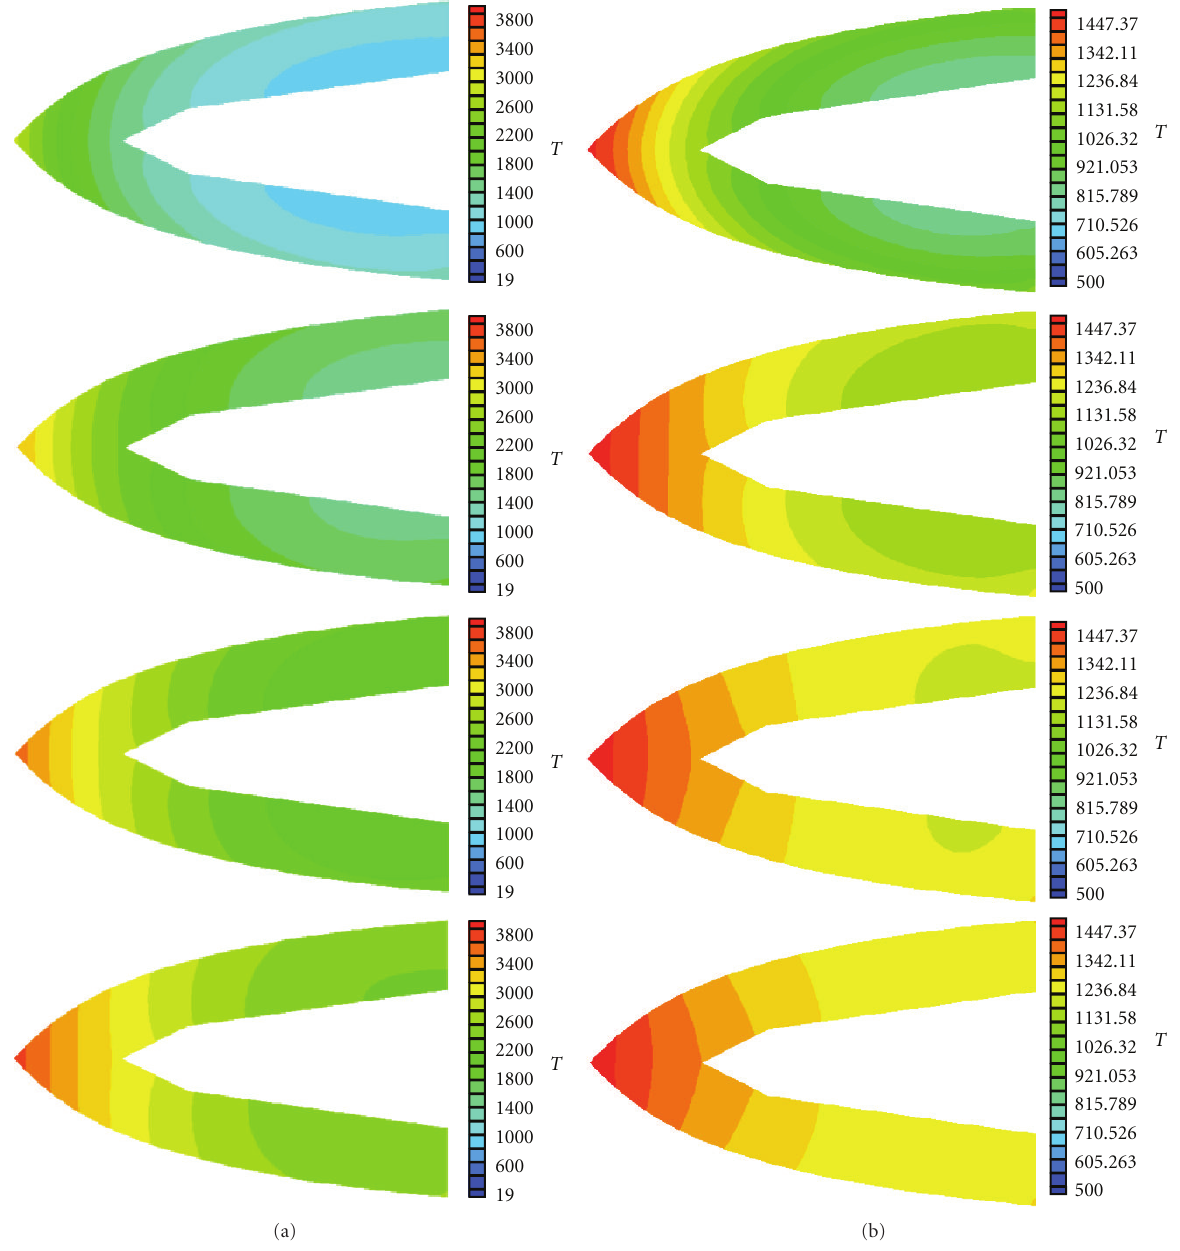
Figure 4: Temperature field within the hollow cone without (a) and with (b) radiation e ff ects at time points t = 25s, 50s, 75 s, and 100 s.